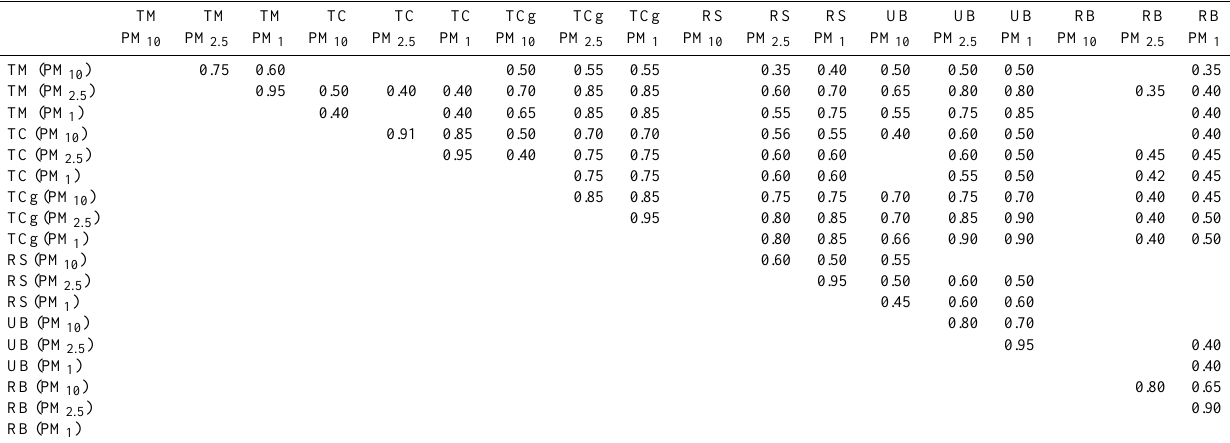
Table 6. Correlation table of aerosol mass loadings during SAPUSS. Correlations ( R 2 ) lower than 0.3 are omitted in this table. TM TM TM TC